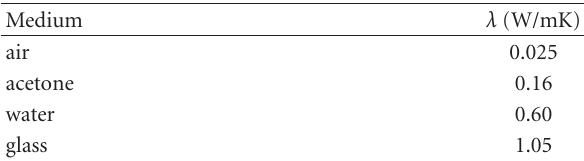
Table 2: Thermal conductivity ( λ ) of the glass, air, acetone and wa- ter.